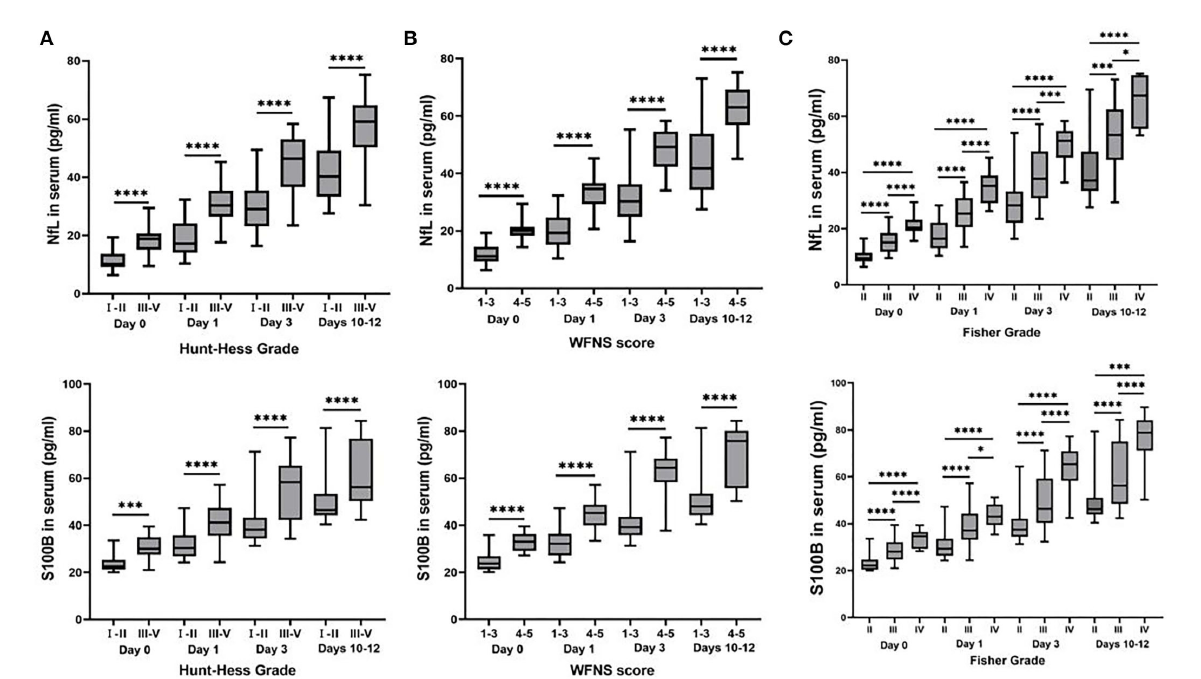
FIGURE2 Box plots of concentrations of inflammatory cytokines classified by Hunt-Hess grade, World Federation of Neurological Surgeons (WFNS) grade, and Fisher grade. The serum NfL and S100B levels in patients with aSAH were considerably different from those various evaluations of neurological diseases. (A) The higher levels of serum NfL and S100B were detected in aSAH patients with H-H grades III and IV, compared with gradesIand II at each time point ( P < 0.01). (B) Serum NfL and S100B levels were much higher in aSAH patients with WFNS scores of 4 and 5 than those with WFNS scores of 1–3 at each time point ( P < 0.0001). (C) The serum NfL and S100B concentrations in aSAH patients differed significantly in various Fisher grades at each time point ( P < 0.05). All data were presented as mean ± SEM. * P < 0.05; ** P < 0.01; *** P < 0.001; **** P <